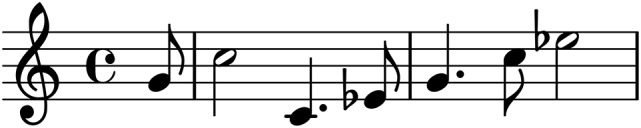
The Schwert-Motiv in C minor.